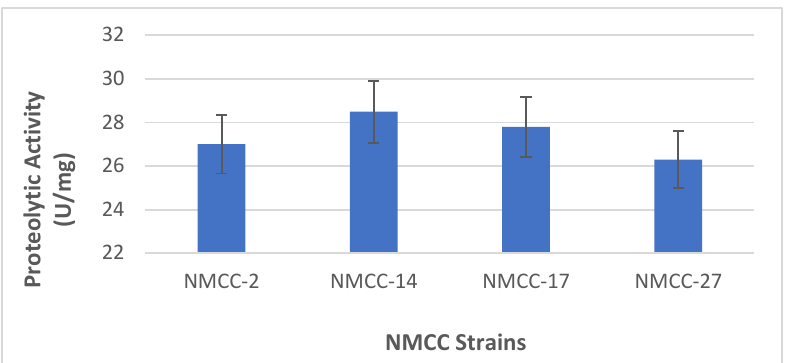
Figure 3. Proteolytic potential of the isolated LAB strains.